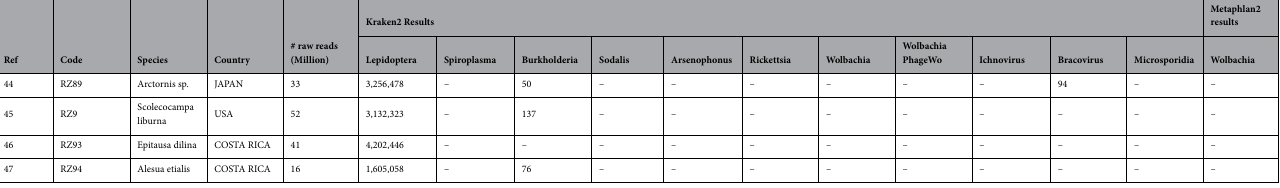
Table 1. The number of reads classified as originating from the host and various microorganisms. Values in bold highlight the values mentioned in the text, – represent samples with either zero or less than 50 reads classified.